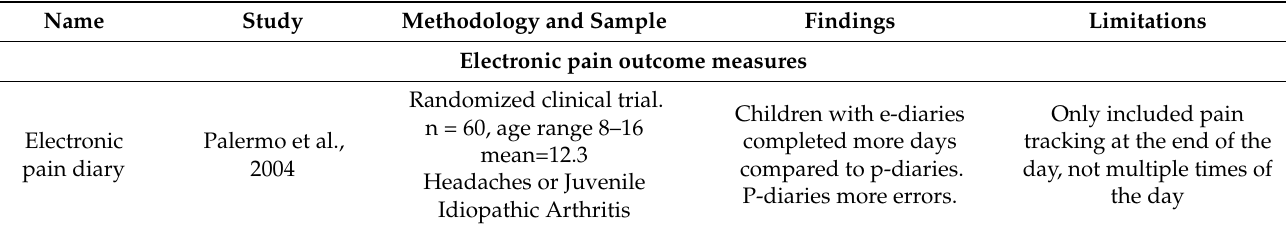
Table 3. Summary of findings and limitations of emerging pain outcome measures